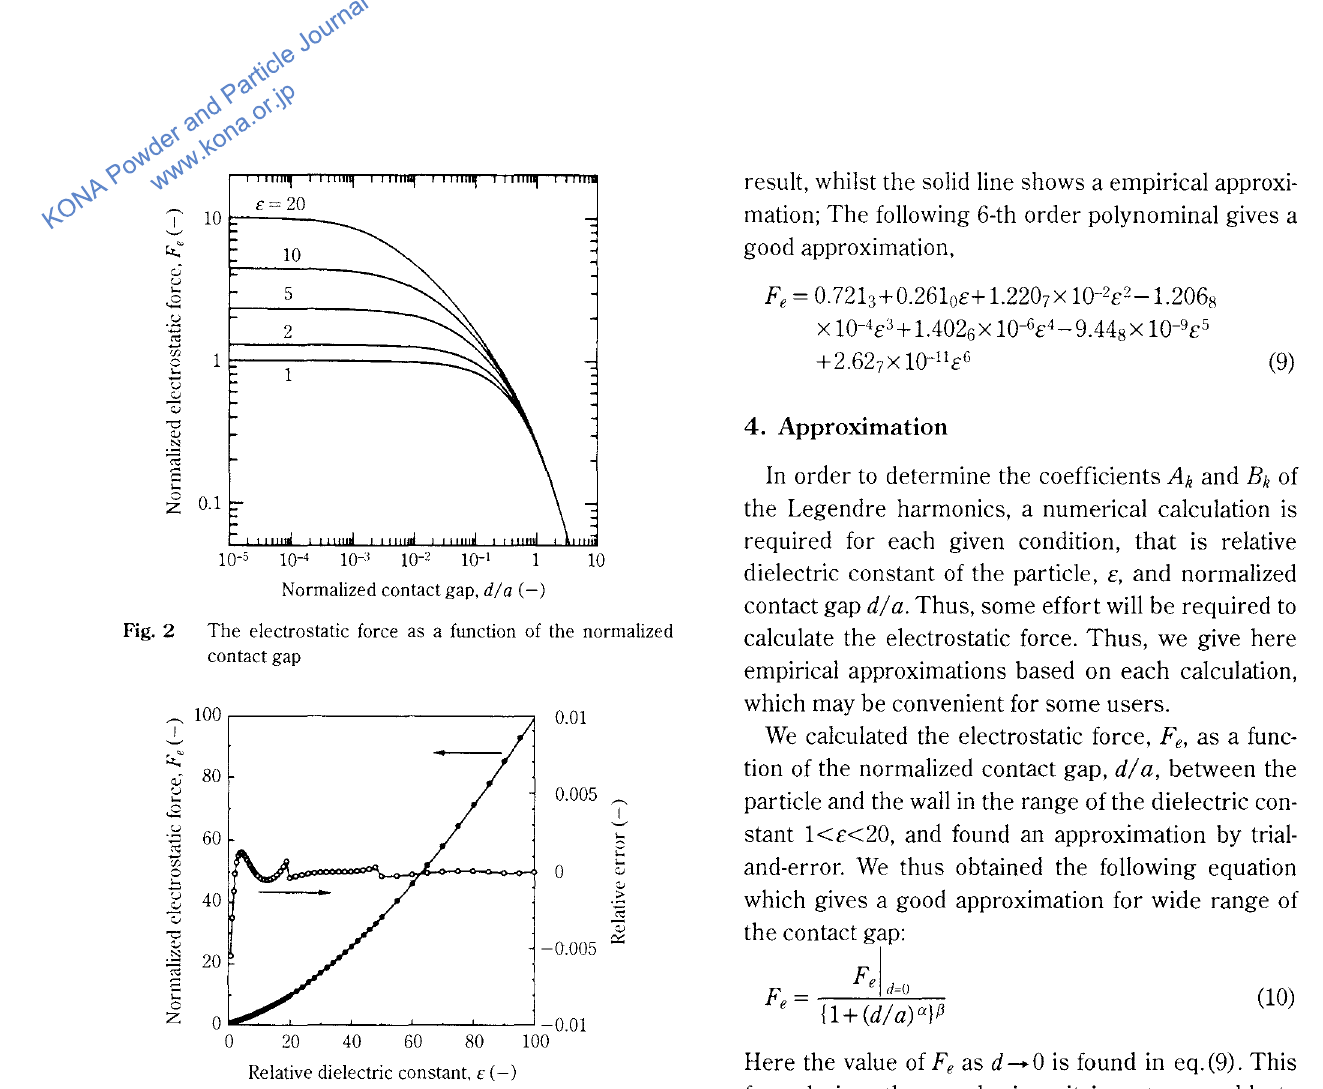
The relation between the electrostatic adhesive force and the relative dielectric constant of the particle as a function of the contact gap between the particle and the conducting plane for 1 <£<20. The higher order polarization show their effect when the contact gap becomes less than the particle radius. This result shows that the attractive force can be bigger, in the case of particles in contact, than that of the normally used point charge approximation depending on the dielectric constant. The effect of the polarization is negligible in the case of particles farther from the wall than the particle radius. These results agree with